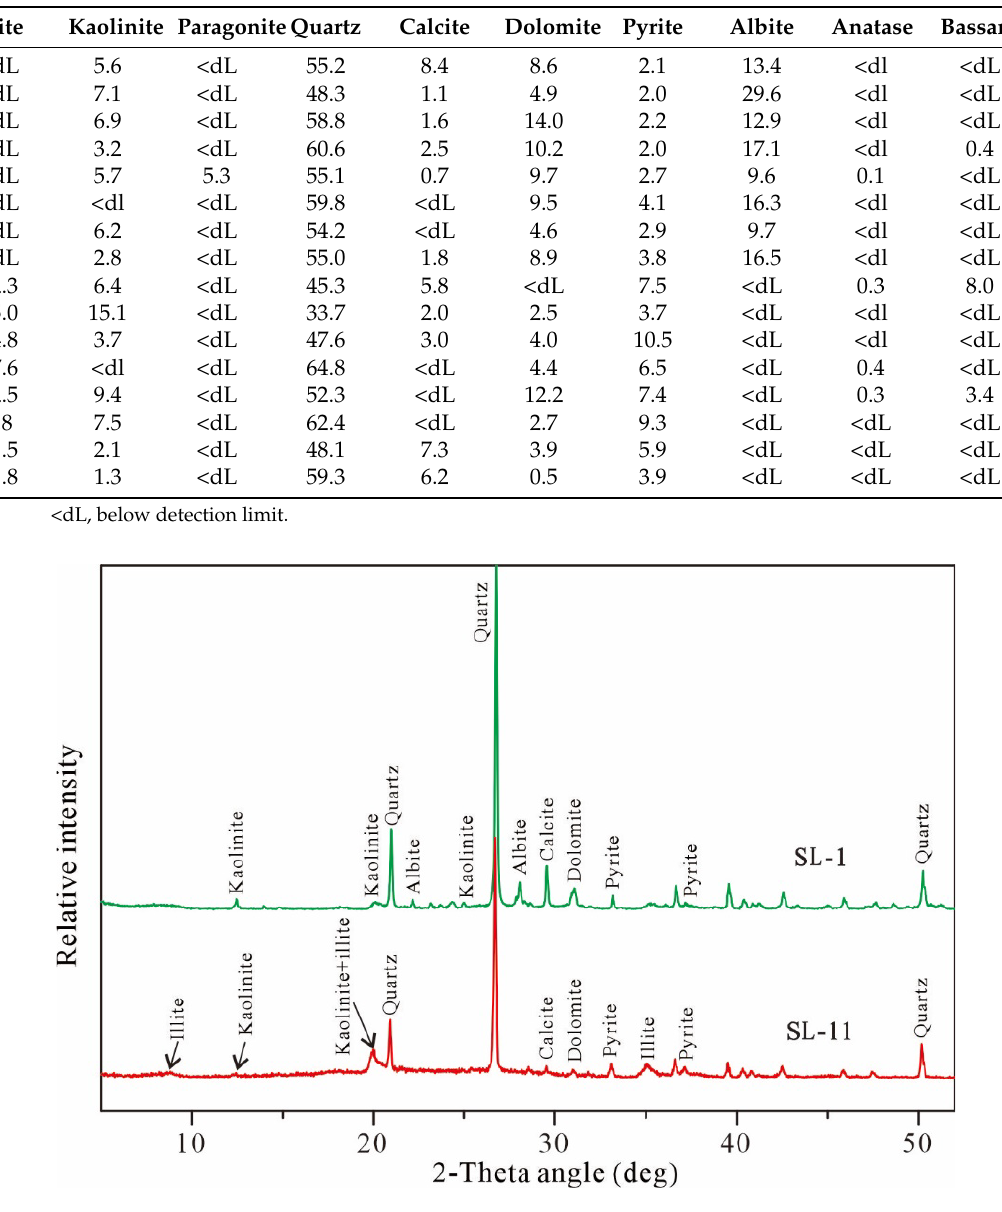
Table 2. Mineralogical proportions and low-temperature ash yield (LTA) of the samples from the borehole SL (on whole-coal basis; unit in wt%). Sample